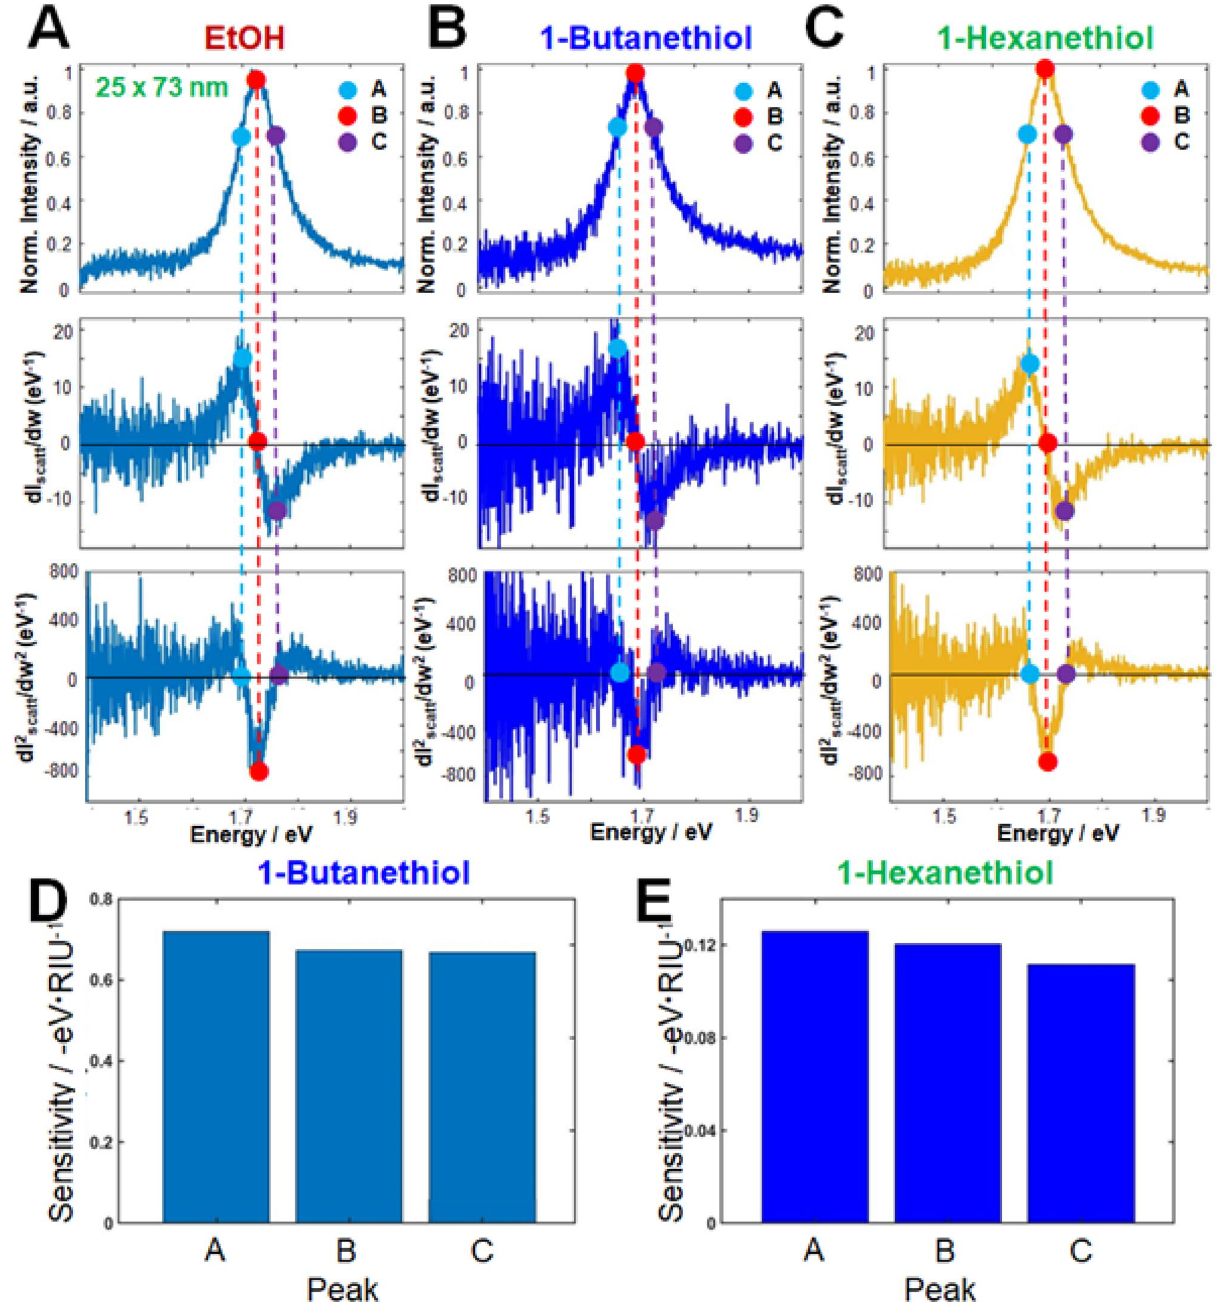
Figure 6. Inflection-point method for single-particle LSPR scattering sensing with AuNRs (25 nm × 73 nm, AR = 2.9) in the presence of 1-alkanethiols (1-butanethiol and 1-hexanethiol) in ethanol: ( A–C ) LSPR scattering efficiencies (first row), and their first-order (second row), and second-order (third row) derivatives; ( D, E ) Detection sensitivities of peak shifts in A, B and